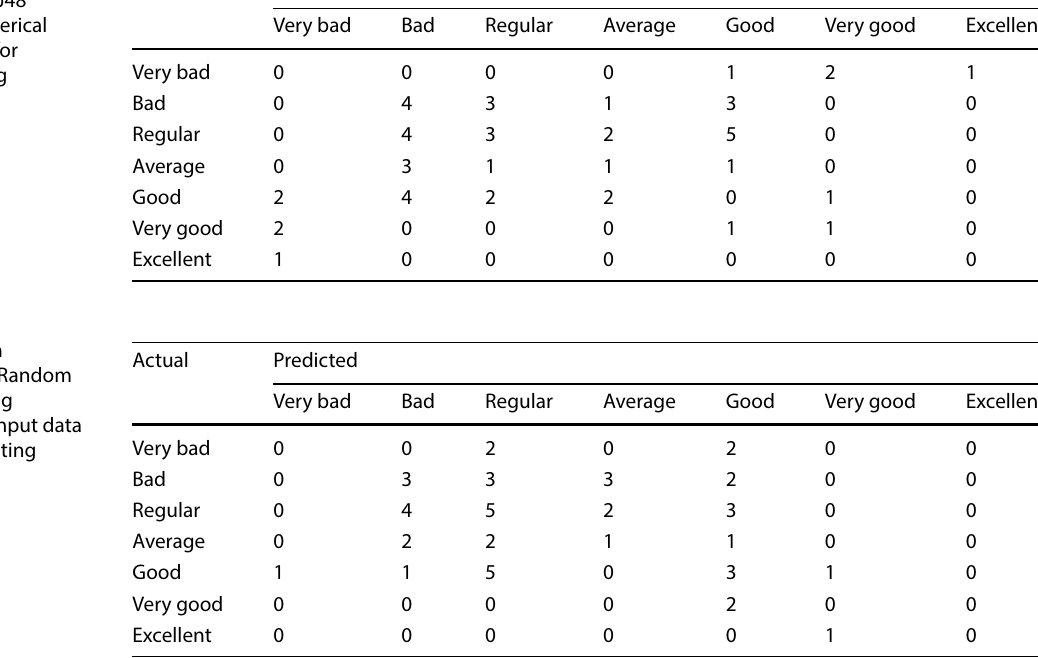
Table 6 Classification confusion matrix via J48 algorithm using numerical values as input data for categorical predicting